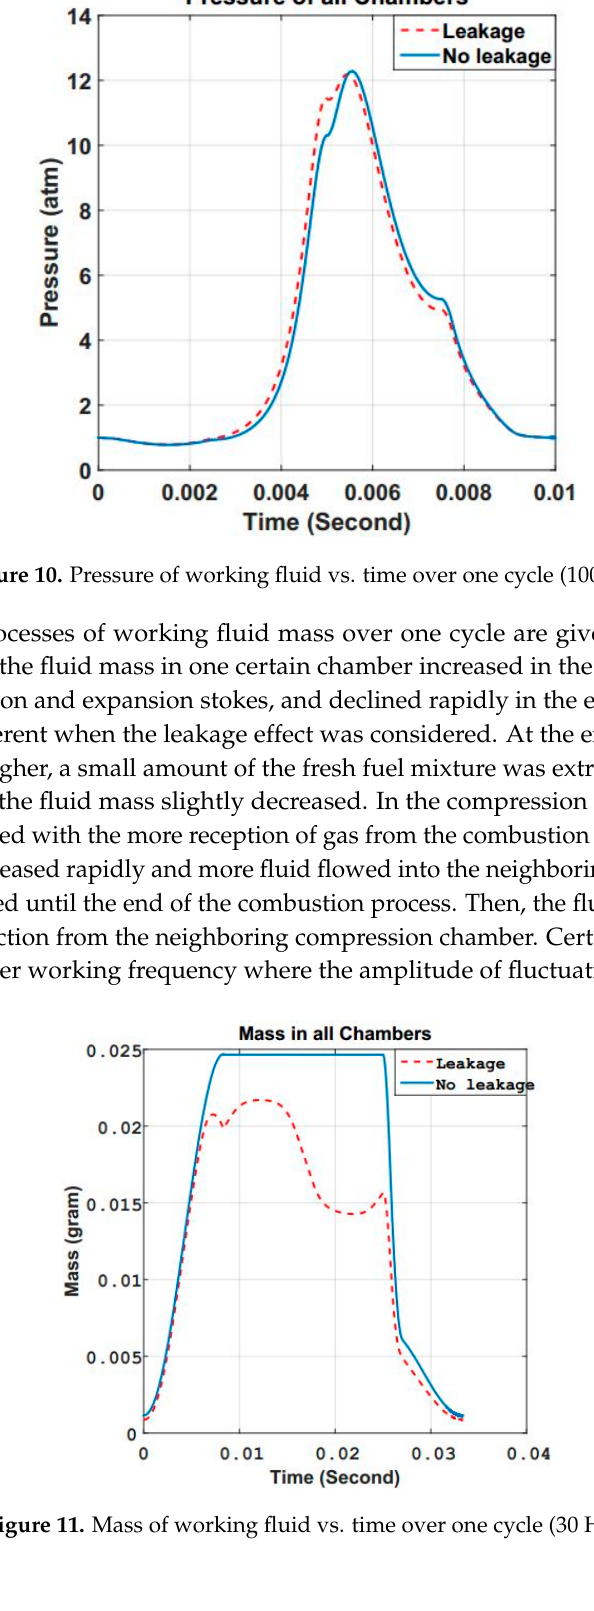
Figure 9. Pressure of working fluid vs. time over one cycle (30 Hz).